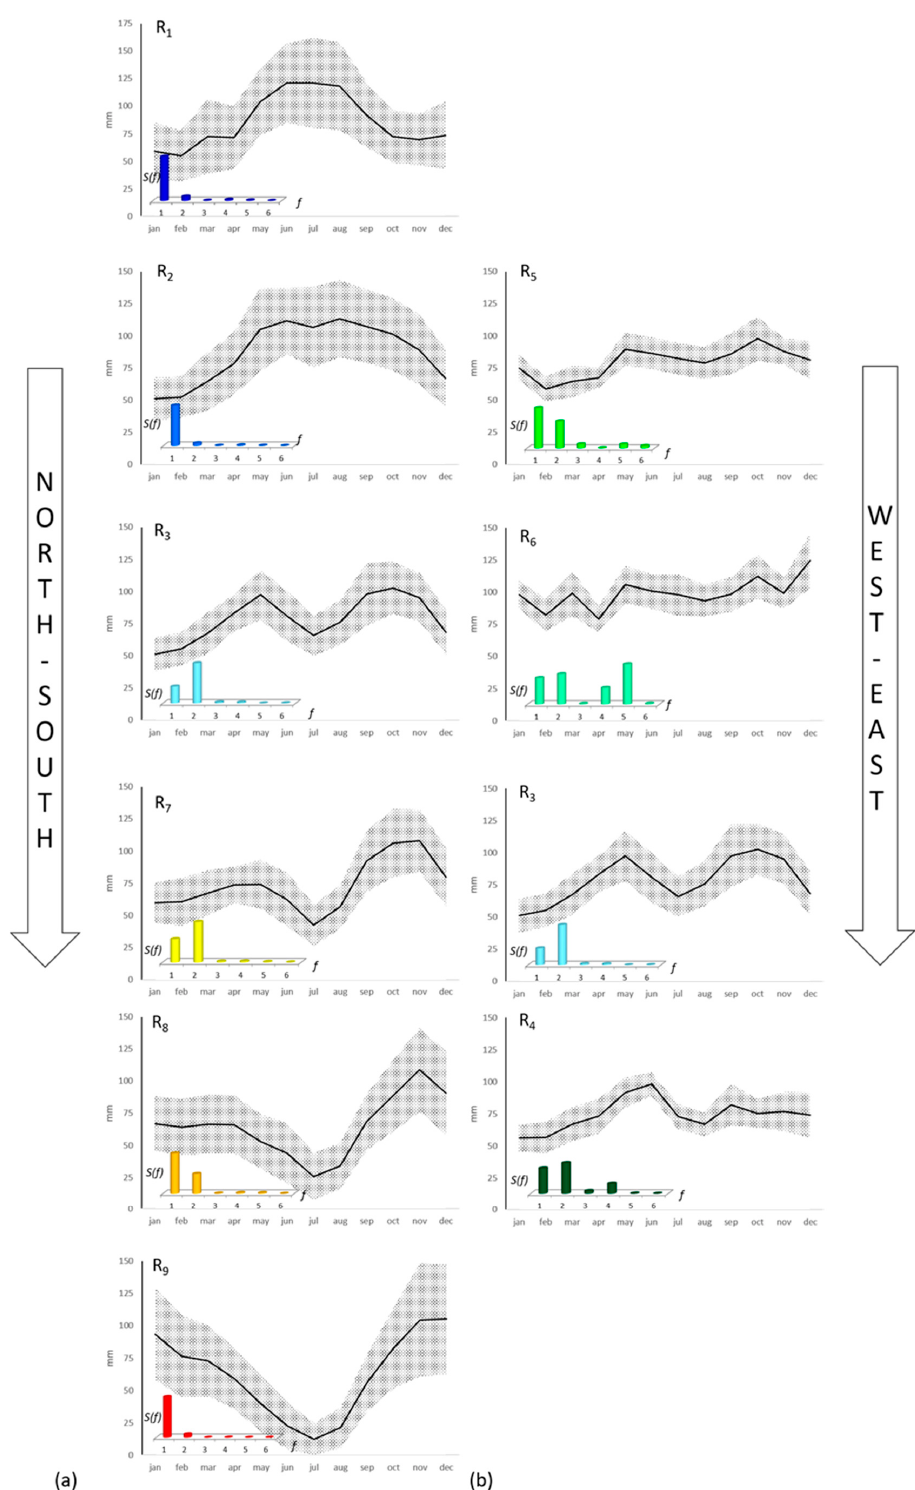
Figure 7. Seasonal curves (centroids) for the regions in Figure 6b: ( a ) North-to-South sequence; ( b ) West-to-East sequence. Dotted areas sign the ± σ ( m ) band around the centroids, where ± σ ( m ) is the standard deviation of the monthly means within the given cluster. Plots include the variance power spectra S ( f ) [47] estimated for the seasonal curves and normalized to S (1). The height of the bars represents the variance explained by each frequency (cycles per year) relative to the variance explained by annual